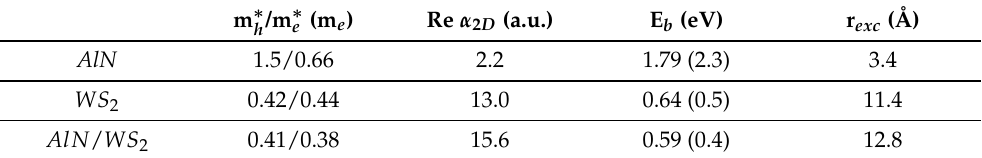
Table 3. The excitonic binding energies of the first bright excitons calculated within the BSE. In paren- theses, the values obtained within the 2D excitonic model are reported. In the last column, we report also the excitonic radius r exc obtained using the same model. In the second column are reported the hole and electron effective masses, m ∗ , while in the third one are shown the values of the real part of the static